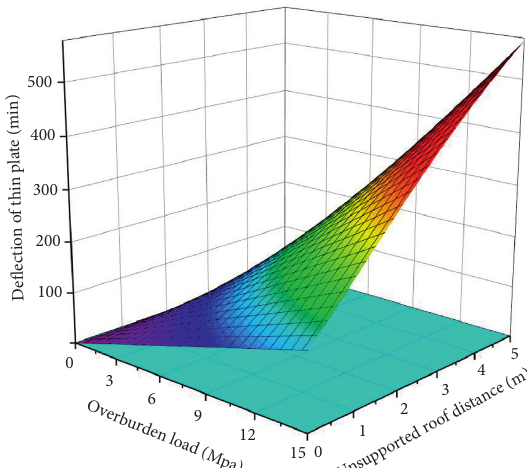
Figure 8: The response surface of roof deflection and deformation under unsupported roof distance and load.